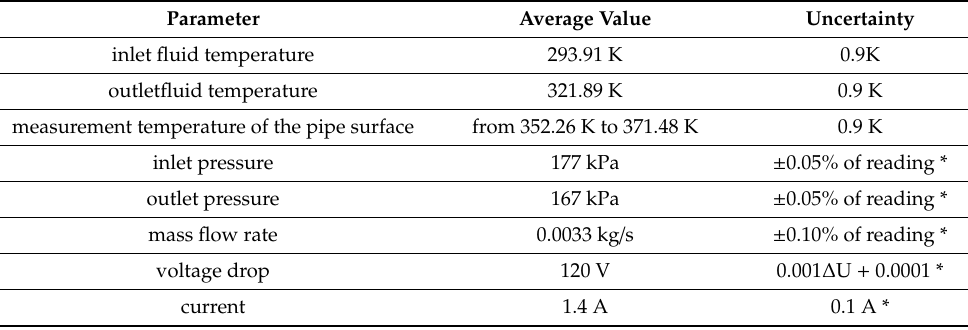
Table 2. Average values of parameters of the experiment and the uncertainties. Parameter